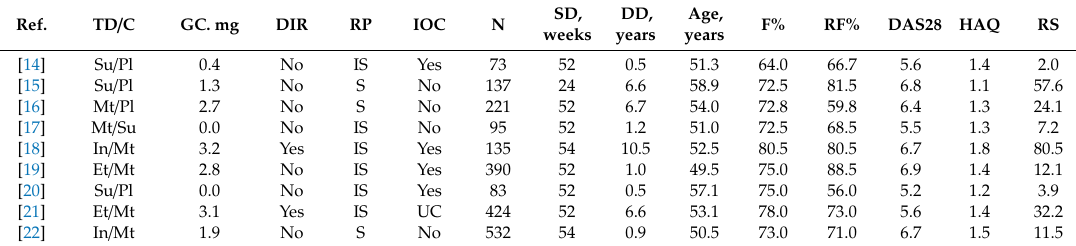
Table 1. Baseline study characteristics.